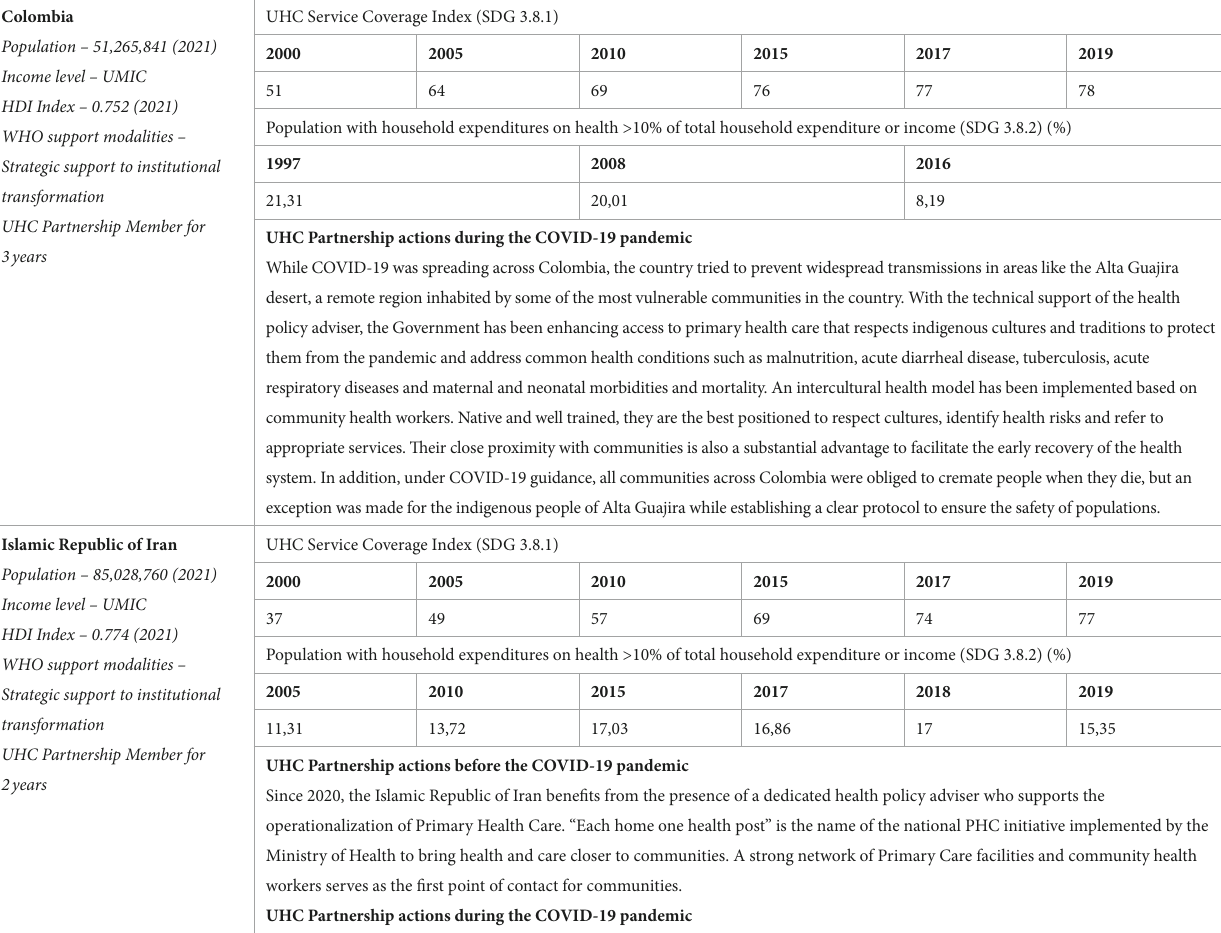
TABLE 1 Country examples of technical assistance for resilient and integrated health systems (46–48).